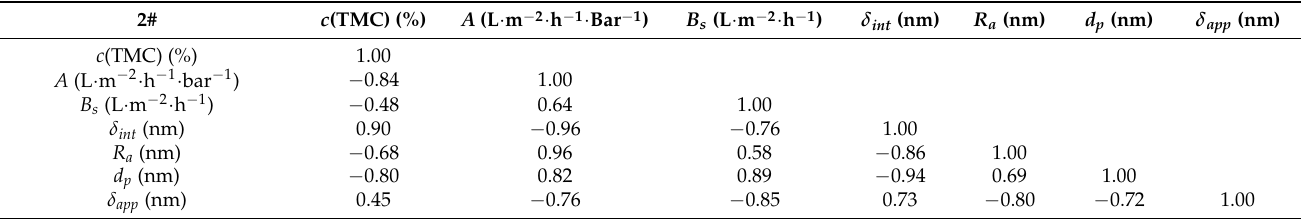
Table 4. The analysis of correlation coefficients in series 2.